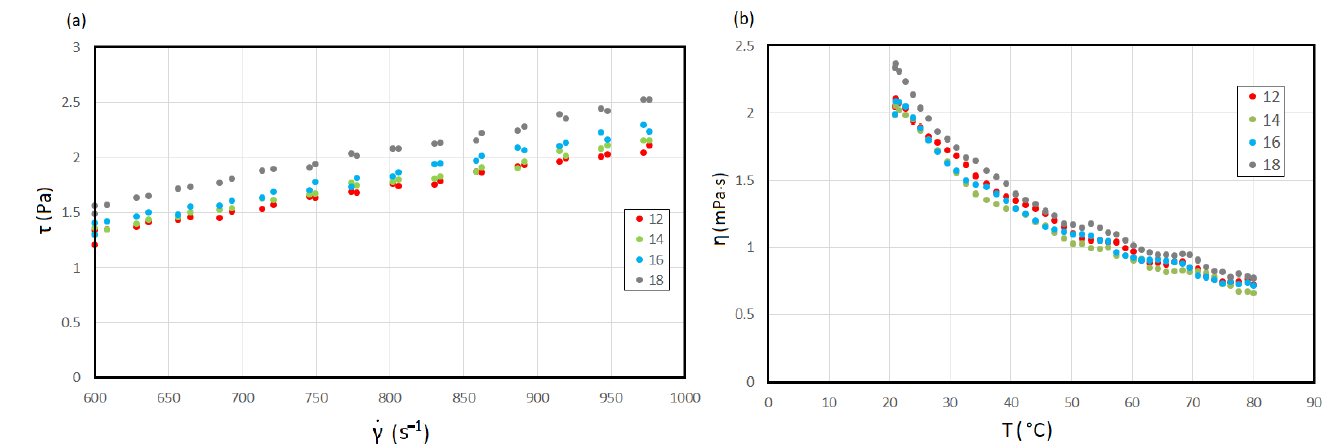
Figure 4. Beer worts: ( a ) viscosity curve; ( b ) viscosity as a function of temperature.